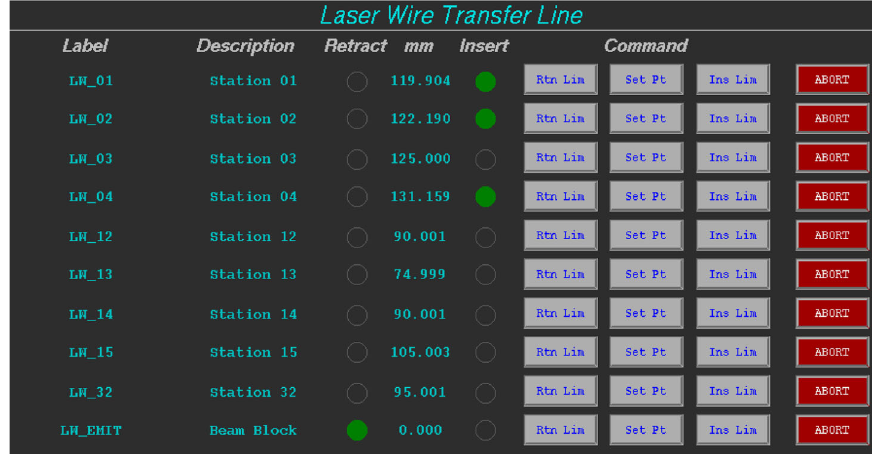
FIG. 5. Extensible display manager (EDM) screen of the laser wire transfer line control for simultaneous scans. The user can set up positions of all pickup optics separately. The lowest button in the list, LW_Emit, stands for the HEBT laser emittance measurement system which measures the transverse emittance of the ion beam using the same light source [9]. The laser emittance measurement setup is not included in the present simultaneous scan